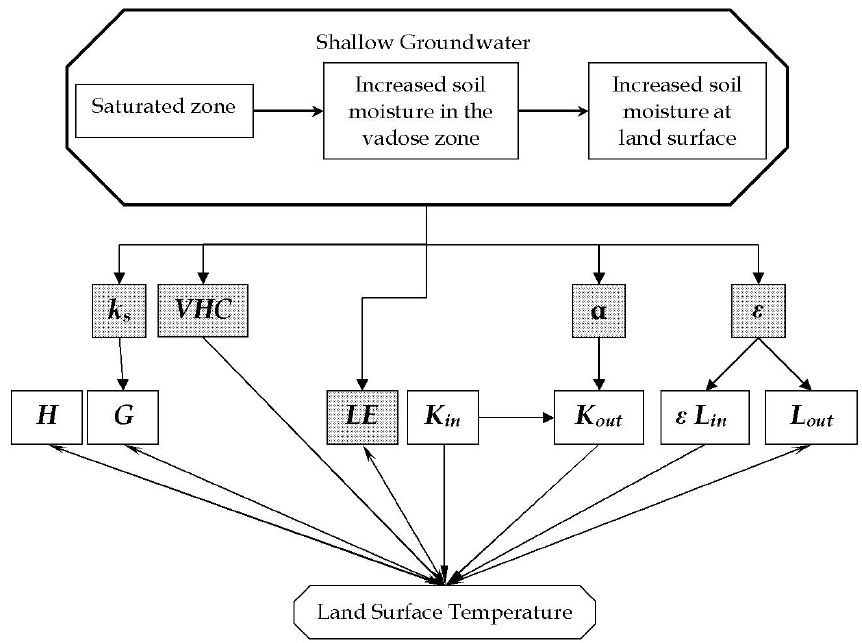
Fig. 1. A schematic description of the effect of shallow groundwater on the land surface temperature and the different components of the surface energy